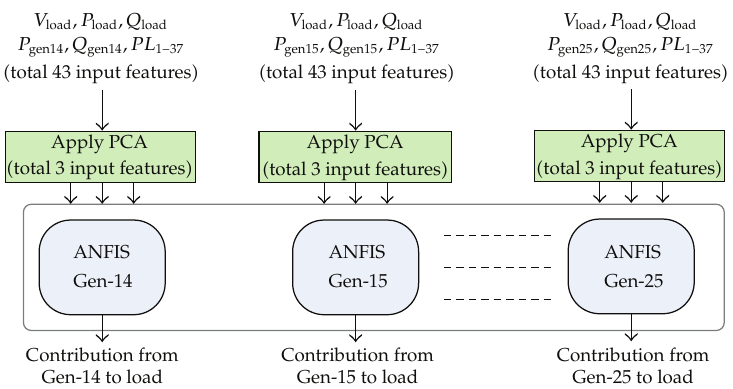
Figure 4: ANFIS design for real power transfer allocation for the